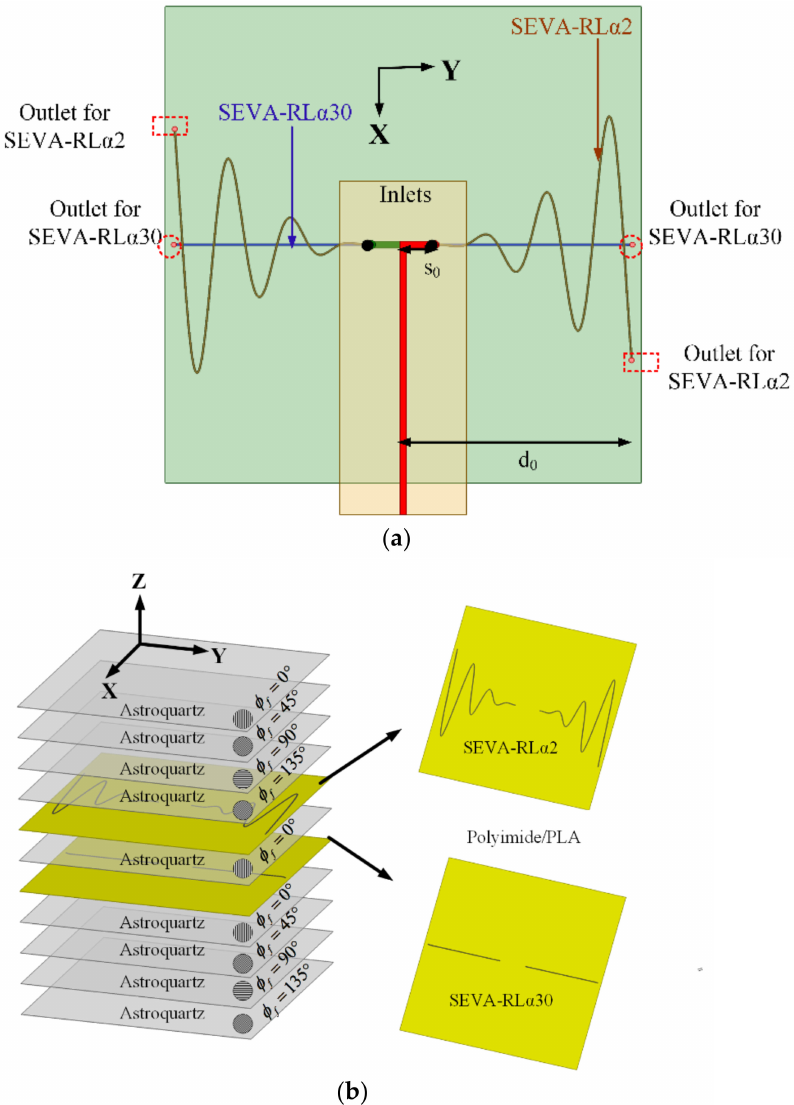
Figure 1. Detailed representation of multi-layer structurally embedded vascular antennas (ML-SEVA) ( a ) CAD model used for simulating the structure ( b ) Fabrication lay-up. The feed structure consists of parallel strips connected to the meandering microvascu- lar elements of the antenna through antipodal dipoles; this also forms a balun-like transi- tion [30]. Equations (1) and (2) provide the parameterization of the sacrificial PLA used to create microvascular channels for the ML-SEVA in Figure 1. These meander outward in the y-dir. starting from the feed location y = ± s 0 = ± 10.0 mm and to y = ± d 0 = ± 72.2 mm and are modulated sinusoidally in the x-dir. with a period p 0 = 2 within a power series envelope with a growth parameter α . In this work, the first vascular network in the lay-up uses α = 2 to provide a sinusoidally-meandering dipole antenna topology referred to as the SEVA-RL α 2. The vascular network on the layer below uses α = 30 to form a quasi-linear dipole-like antenna referred to as the SEVA-RL α 30. The parameter t in these expressions denotes the location of liquid metal, or length of meandering along y-axis in SEVA,